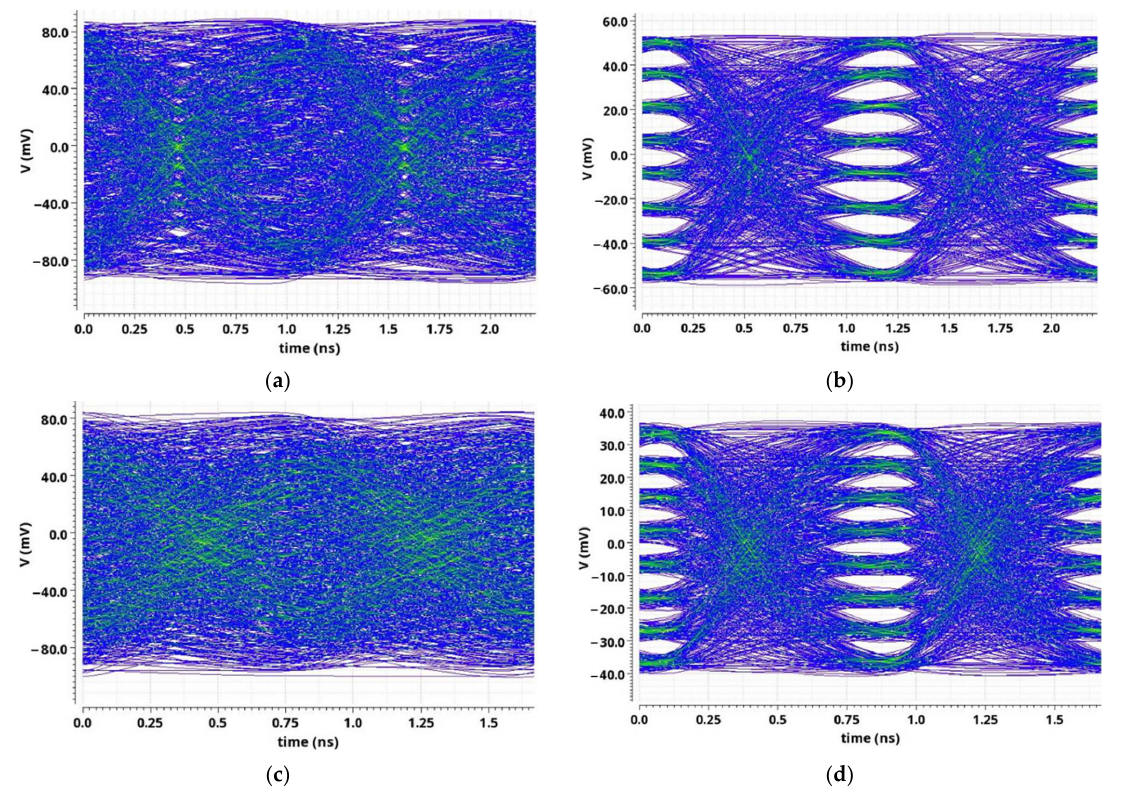
Figure 14. Eye diagrams of PAM-8 signal transmissions with passive equalizers at LED output: ( a ) 2.7 Gbps data rate without FFE; ( b ) 2.7 Gbps data rate with FFE; ( c ) 3.6 Gbps data rate without FFE; ( d ) 3.6 Gbps data rate with FFE.